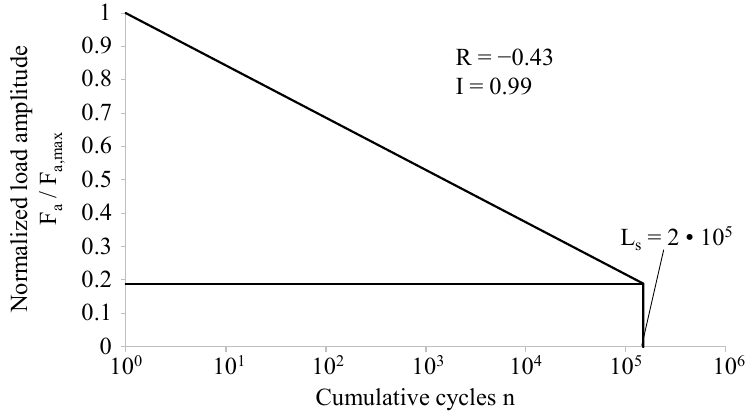
Figure 4. Applied load sequence of the cumulative amplitude distribution, Reprinted with permission from ref. [27]. 2021 International Journal of Fatigue.